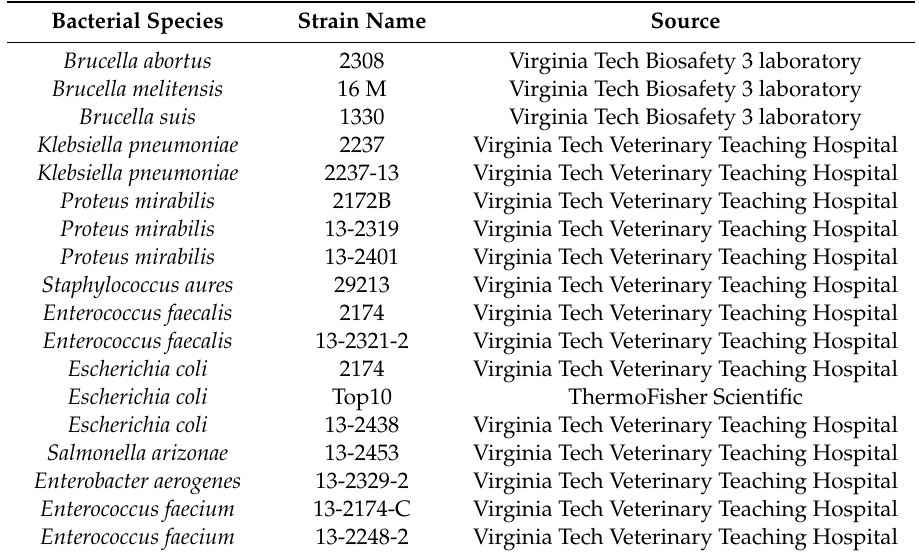
Table 2. Bacterial species and strains